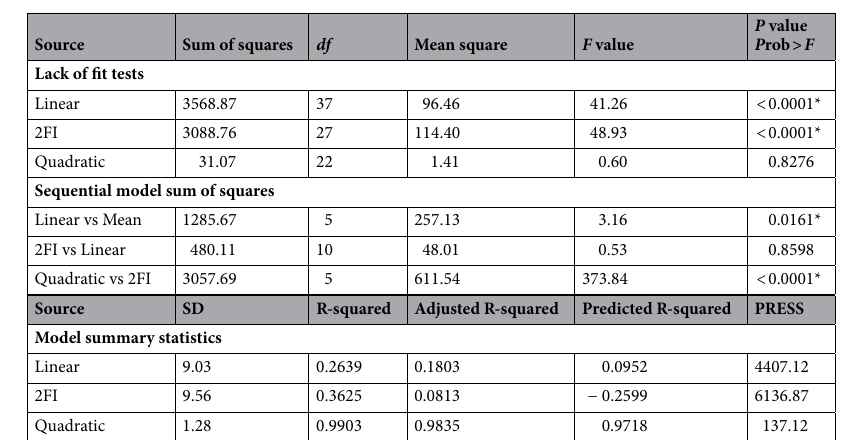
Table 4. Fit summary for FCCCD for adsorption of Remazol brilliant blue dye by using Gelidium corneum biomass results. df degree of freedom, PRESS sum of squares of prediction error, 2FI two factors interaction. *Significant